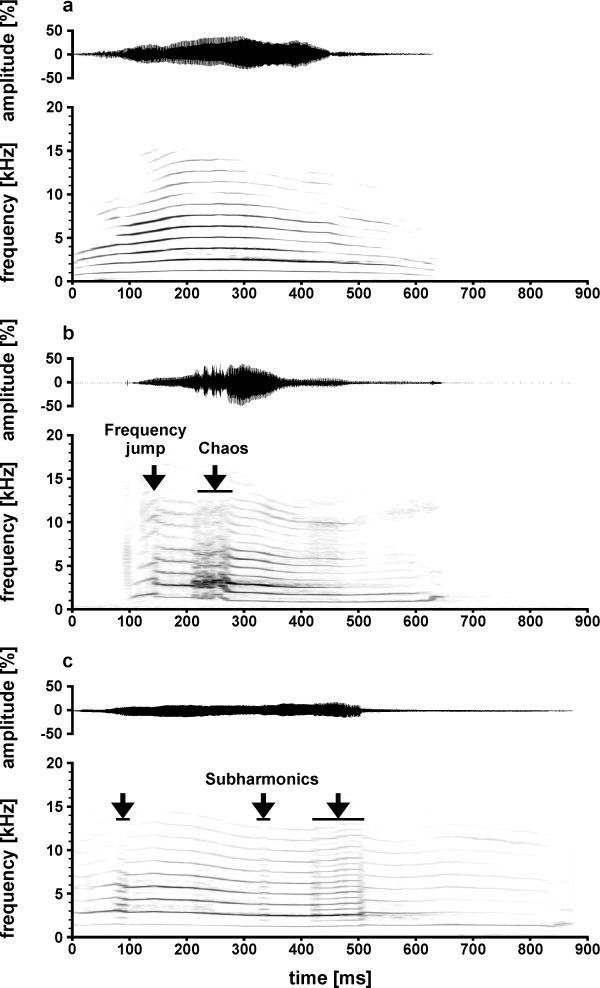
Example of kitten isolation calls; (a) harmonic isolation call without non-linear phenomena, (b) isolation call with a frequency jump and a chaotic component, (c) isolation call with subharmonics.